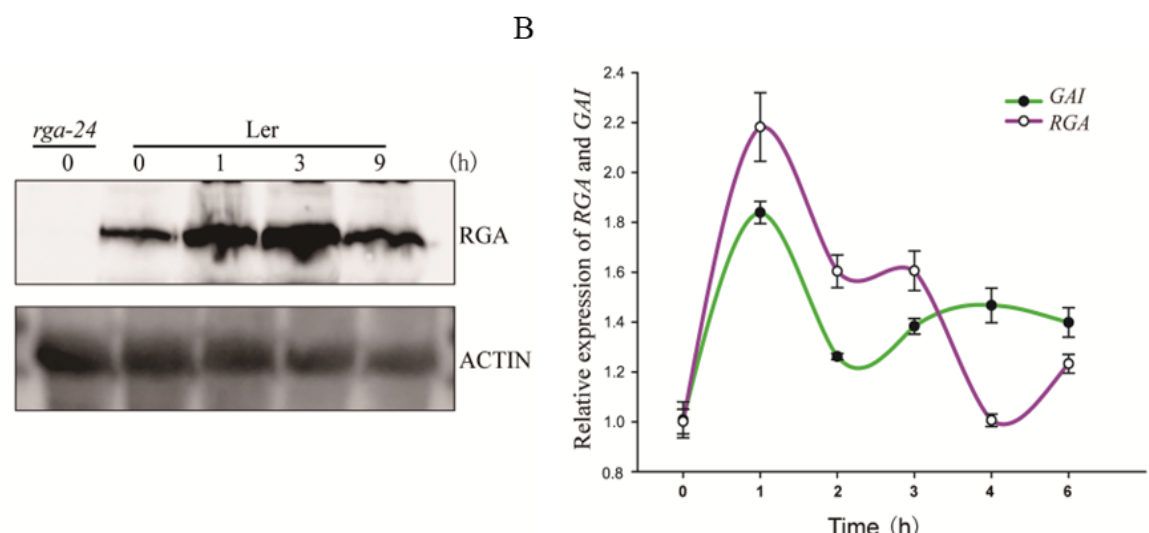
Figure 1. UV-B promotes DELLA accumulation by inducing GA inactivation. ( A ) Wild type (Ler ) was exposed to UV-B radiation of 0.6 W/m 2 for 0 h, 1 h, 3 h, and 9 h after growing under white light for 7 days, and then the content of RGA protein was measured. Actin is shown as a protein- loading control. ( B ) The expression of RGA and GAI under different periods of UV-B irradiation (irradiation intensity is the same as with ( A )). Ler was transferred to UV-B radiation for 0 h, 1 h, 2 h, 3 h, 4 h, and 6 h after growing under white light for 6 days. Error bars represent the SE of three biological replicates.